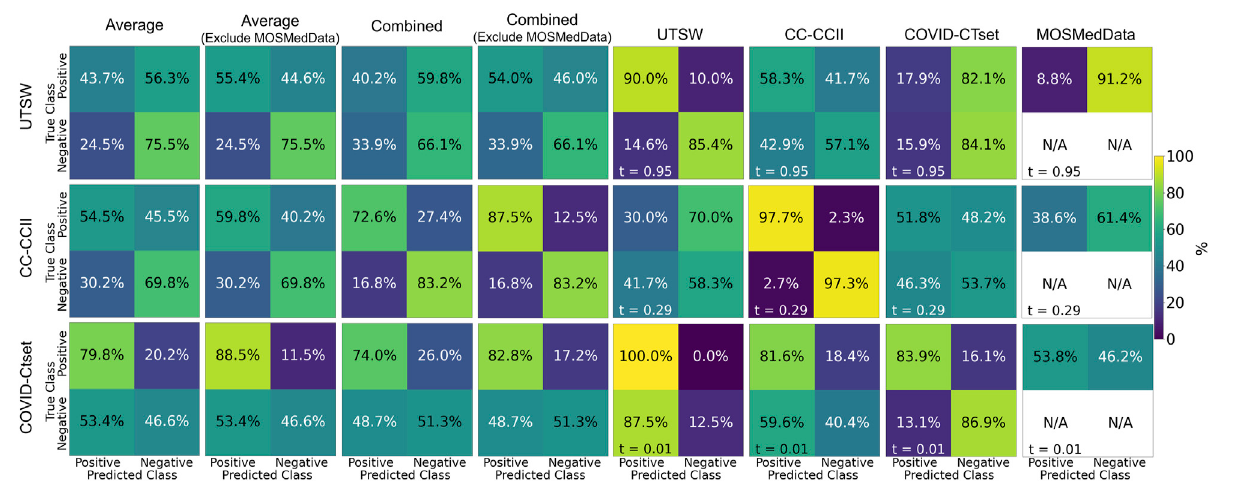
Frontiers in Arti fi cial Intelligence |